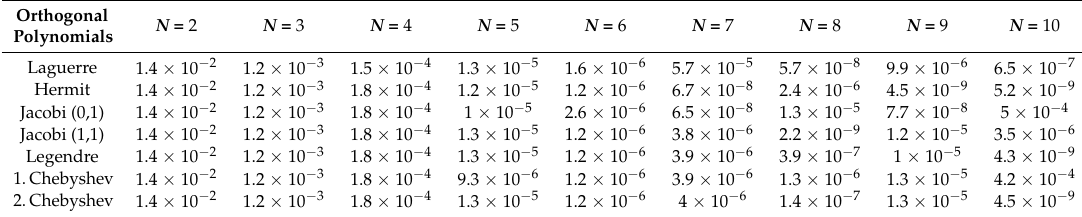
Table 2. Maximum error for Example 6 using the collocation point (a).